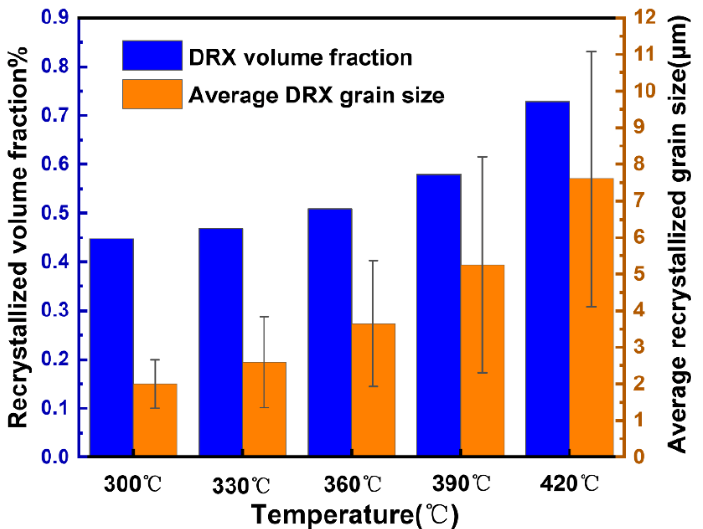
Figure 9. The GOS maps of the 13Zn alloy deformed to a 0.69 true strain at different temperatures with a strain rate of 0.1 s – 1 : ( a ) 300 °C; ( b ) 330 °C; ( c ) 360 °C; ( d ) 390 °C; ( e ) 420 °C.